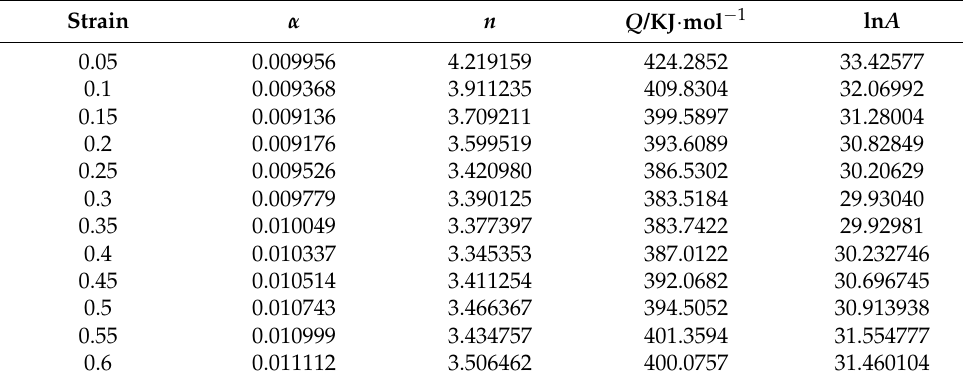
Table 6. Material parameters Q , n , α and ln A under different